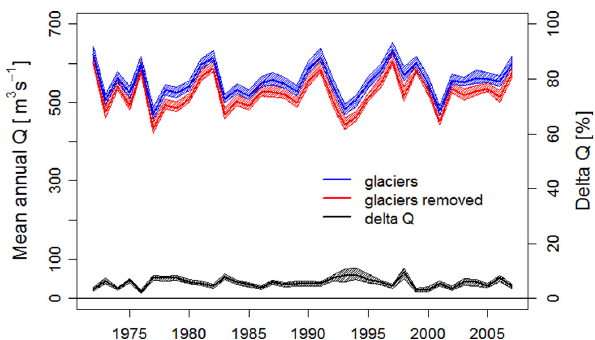
Fig. 6. The effect of glaciers on mean annual discharge shown by comparing simulations with and without glaciers including uncer- tainty limits (5–95% quantile